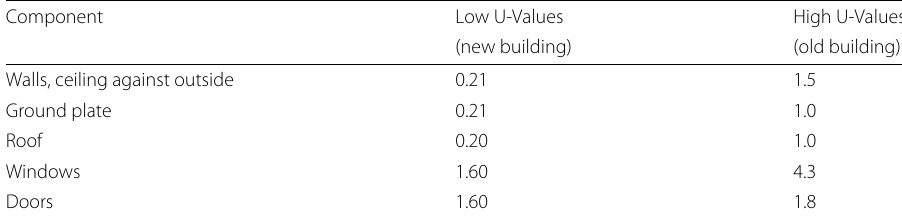
(cid:2) (cid:2) (cid:3)(cid:3) Table 2 U-values W / m 2 K Component Low U-Values High U-Values (new building) (old building) Walls, ceiling against outside 0.21 1.5 Ground plate 0.21 1.0 Roof 0.20 1.0 Windows 1.60 4.3 Doors 1.60